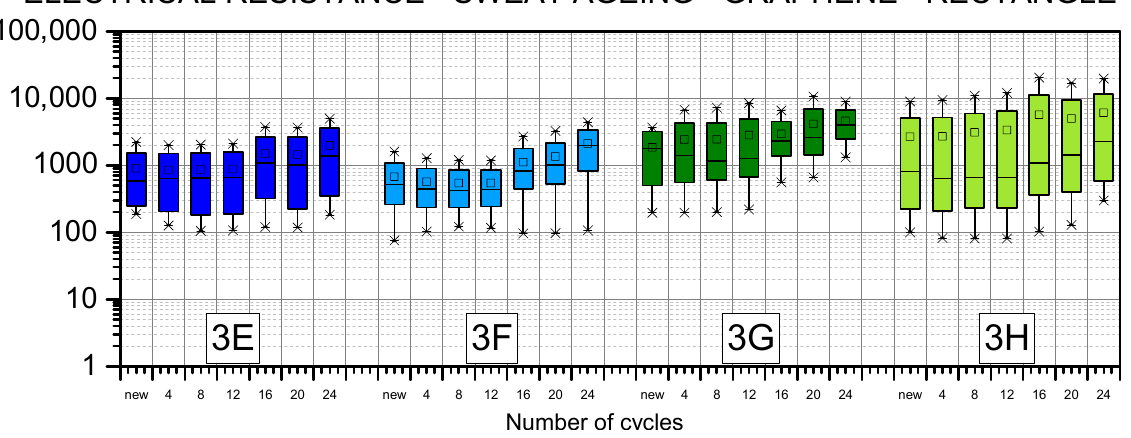
Figure 15. Boxplot diagram of graphene sensor (third sample type—rectangle shape) electrical resistance for samples 3E, 3F, 3G and 3H.